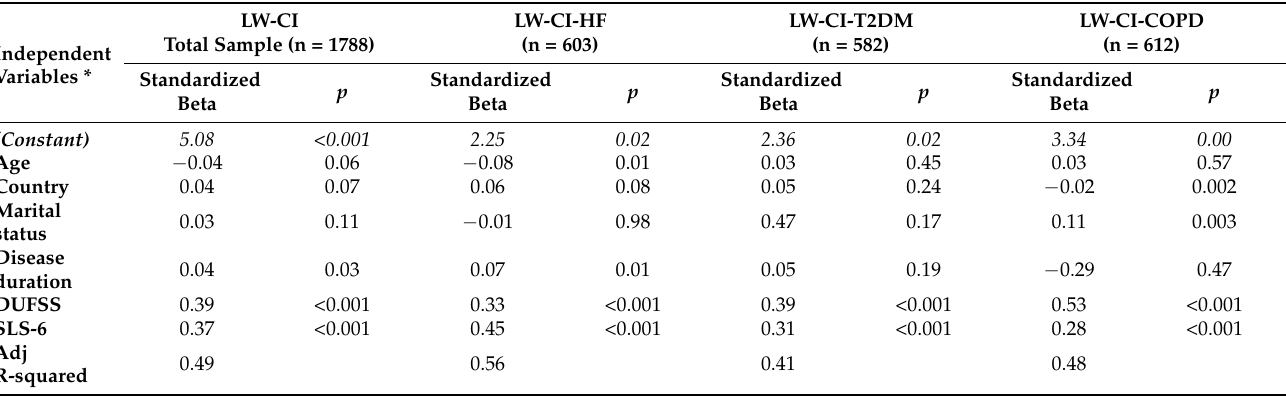
Table 3. Multiple linear regression models.